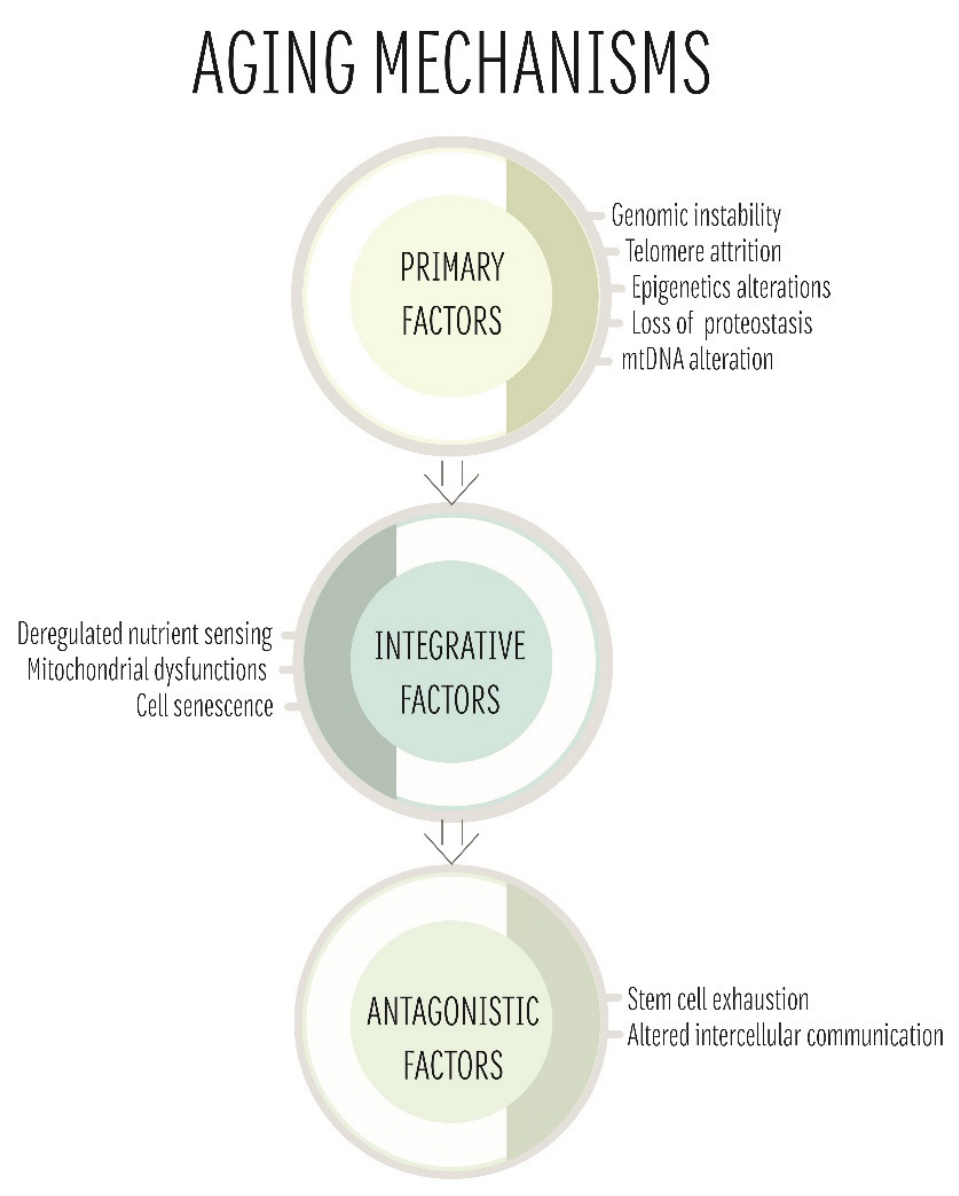
Figure 2. Ageing Figure 2. Ageing mechanisms.